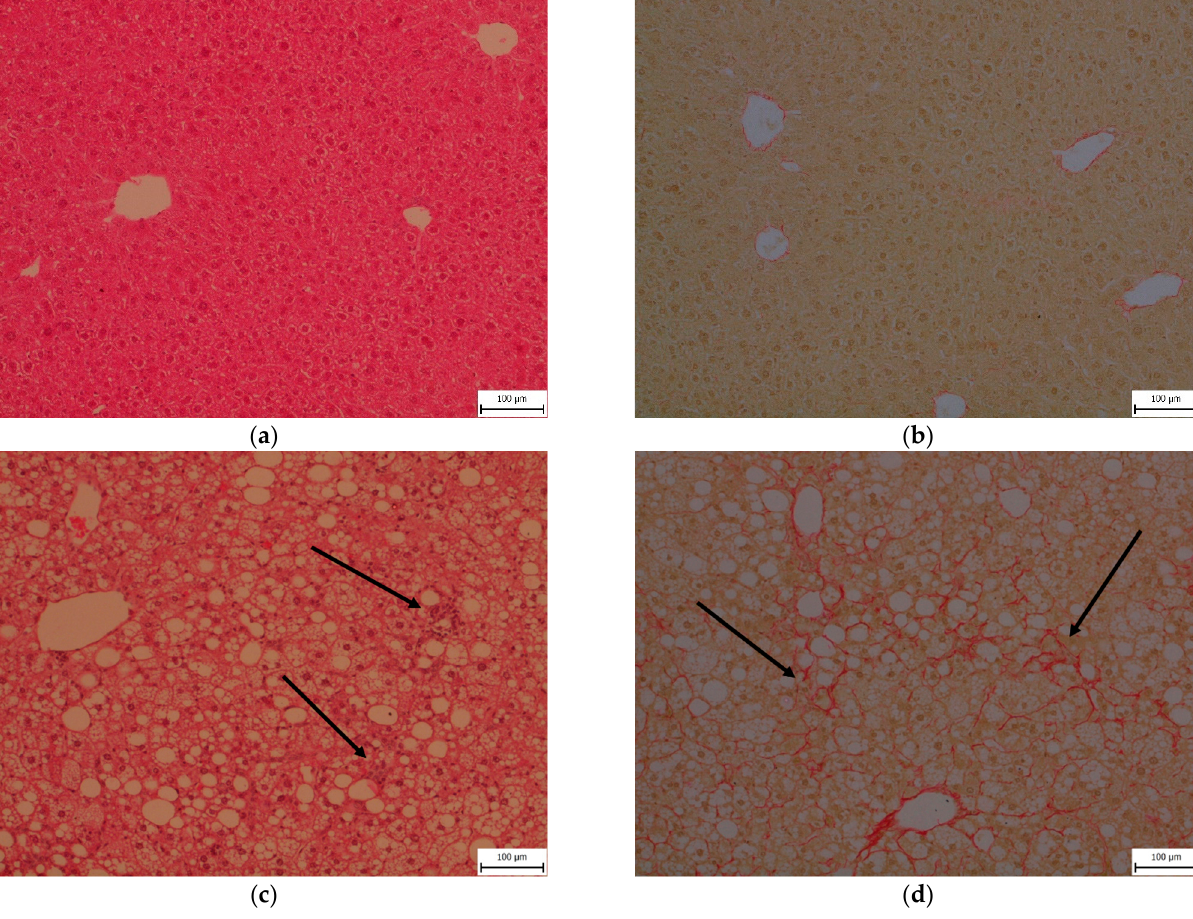
Figure 2. Representative histopathological samples of livers taken from mice fed a control diet ( a , b ) or a Western ‐ style diet ( c , d ) for 30 weeks. Hematoxylin and eosin staining ( a , c ) and sirius red staining ( b , d ). Arrows indicate inflammatory infiltrates ( c ) and fibrosis ( d ).